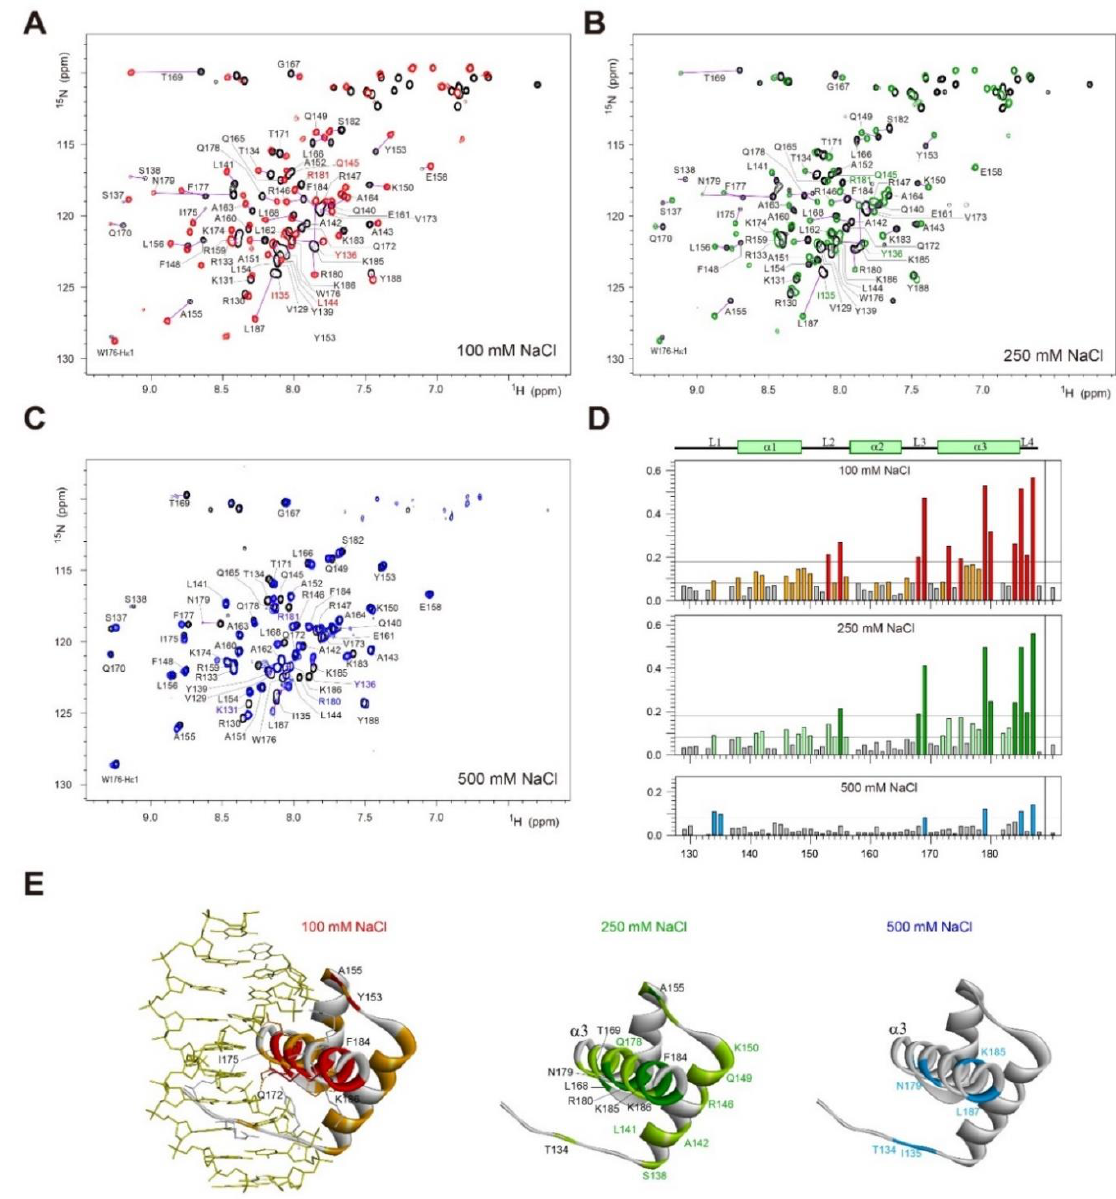
Figure 4. Superposition of 1 H/ 15 N-HSQC spectra of free Dlx3-HD (black) and Dlx3-HD–dlxDNA complex ([N] t /[P] t = 1.5, red, green, or blue) at ( A ) 100 mM, ( B ) 250 mM, or ( C ) 500 mM NaCl at 35 ◦ C. ( D ) The average chemical shift changes ( ∆ δ avg ) in Dlx3-HD upon binding to dlxDNA at 100 mM (upper), 250 mM (middle), or 500 mM NaCl (lower) at 35 ◦ C. ( E ) Mapping the location of the residues with a large ∆ δ avg onto the structure of the Dlx3-HD–dlxDNA complex. The colors used to illustrate the ∆ δ avg are red, green, or blue (>0.18 ppm) and orange, pale green, or light blue (0.08–0.18 ppm) (the same color coding is used in panel ( D )).